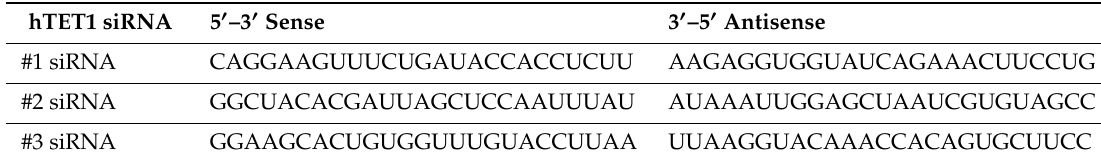
Table 1. The siRNA sequences for TET1 knockdown.